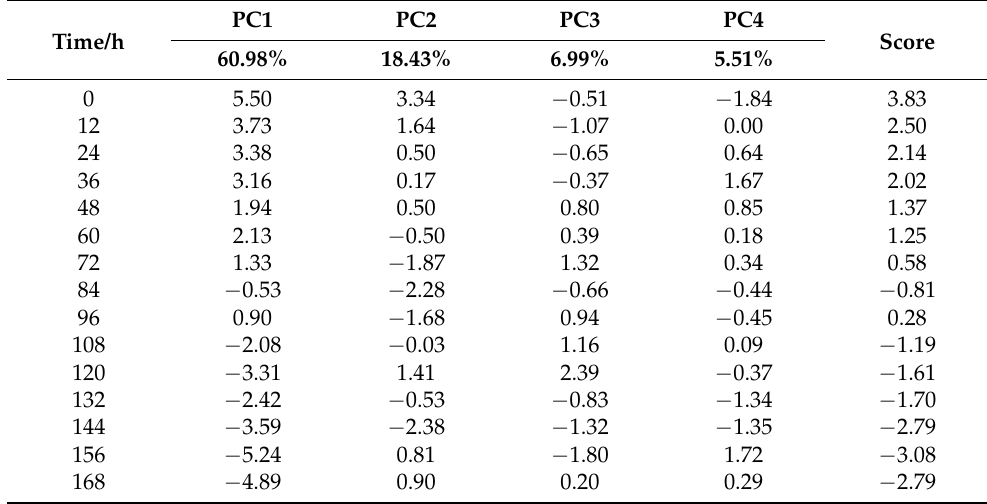
Table 8. Principal components scores of the response values of E-nose and E-tongue for freshly squeezed strawberry juice during cold storage.